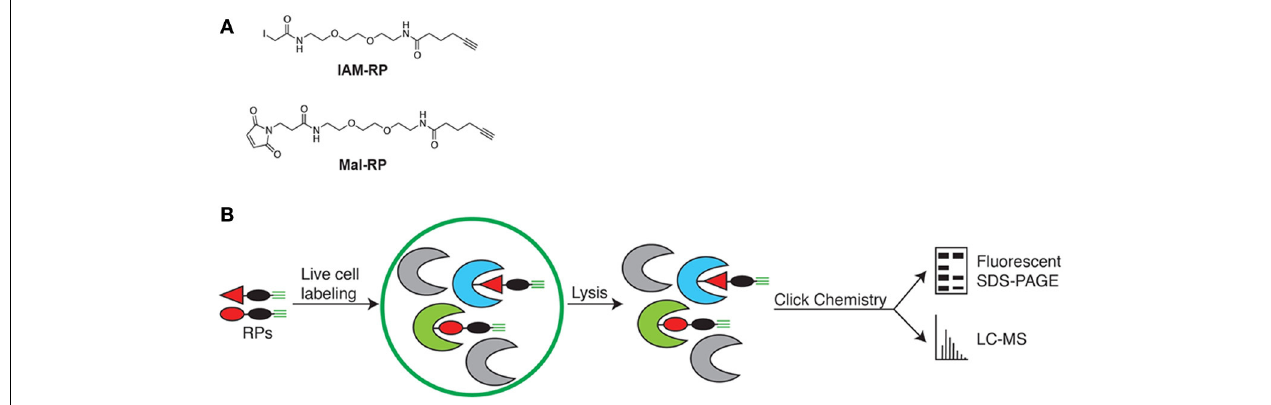
FIGURE 1 | (A) Chemical probes for in vivo labeling of reduced cysteine thiols. IAM-RP and Mal-RP. (B) Schematic of in vivo chemical proteomics approach for analysis of redox-sensitive Synechococcus 7002 proteins.